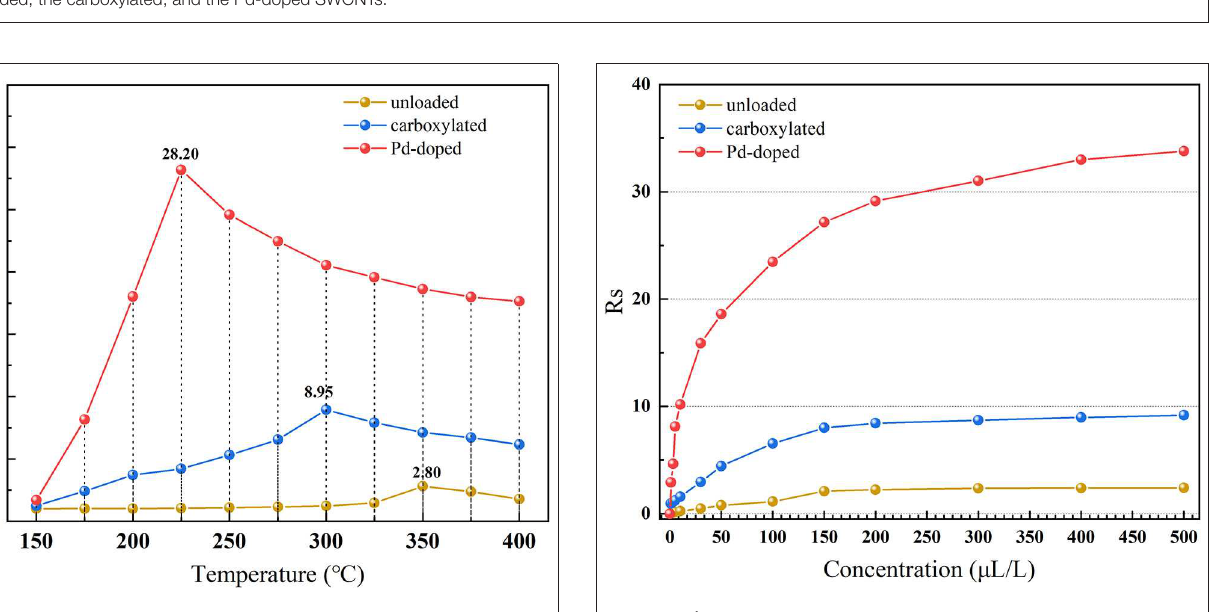
FIGURE 7 | The temperature characteristics of the unloaded, carboxylated, and 3.07 wt% Pd-doped SWCNTs-based gas sensors.